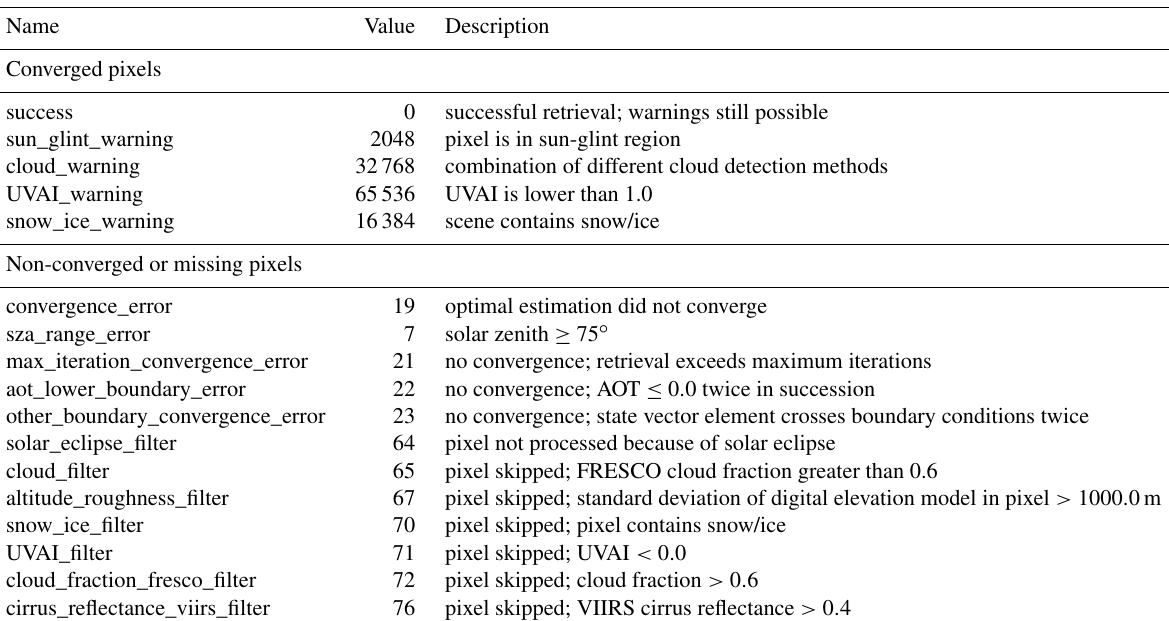
Figure 1. (a) A VIIRS corrected reflectance image over the West African coast on 8 June 2018. (b) All successful TROPOMI retrievals are within a certain bounding box. (c) Same as (b) but with all pixels that possibly fall within the sun-glint region or are cloud contaminated removed (using the cloud_warning flag and sun_glint_warning flag from Table 1). Table 1. Processing quality flags relevant for diagnosing Sentinel-5 Precursor (S5P) ALH product quality. The descriptions are derived from the S5P IODD (Input Output Data